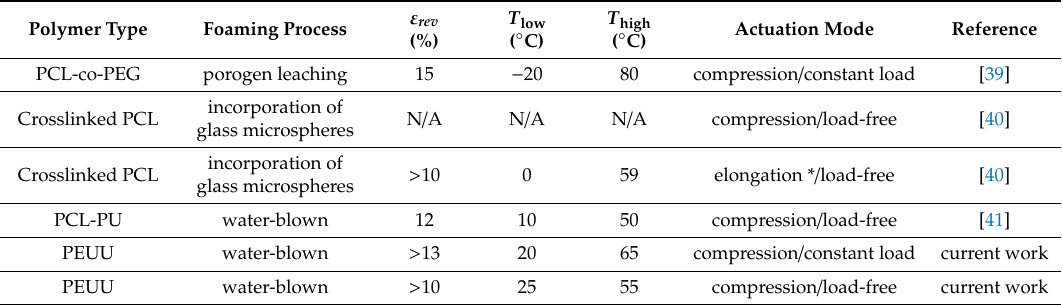
Table 7. Comparison of the PEUU foam with other ones from the literature with regard to their production methods and actuation